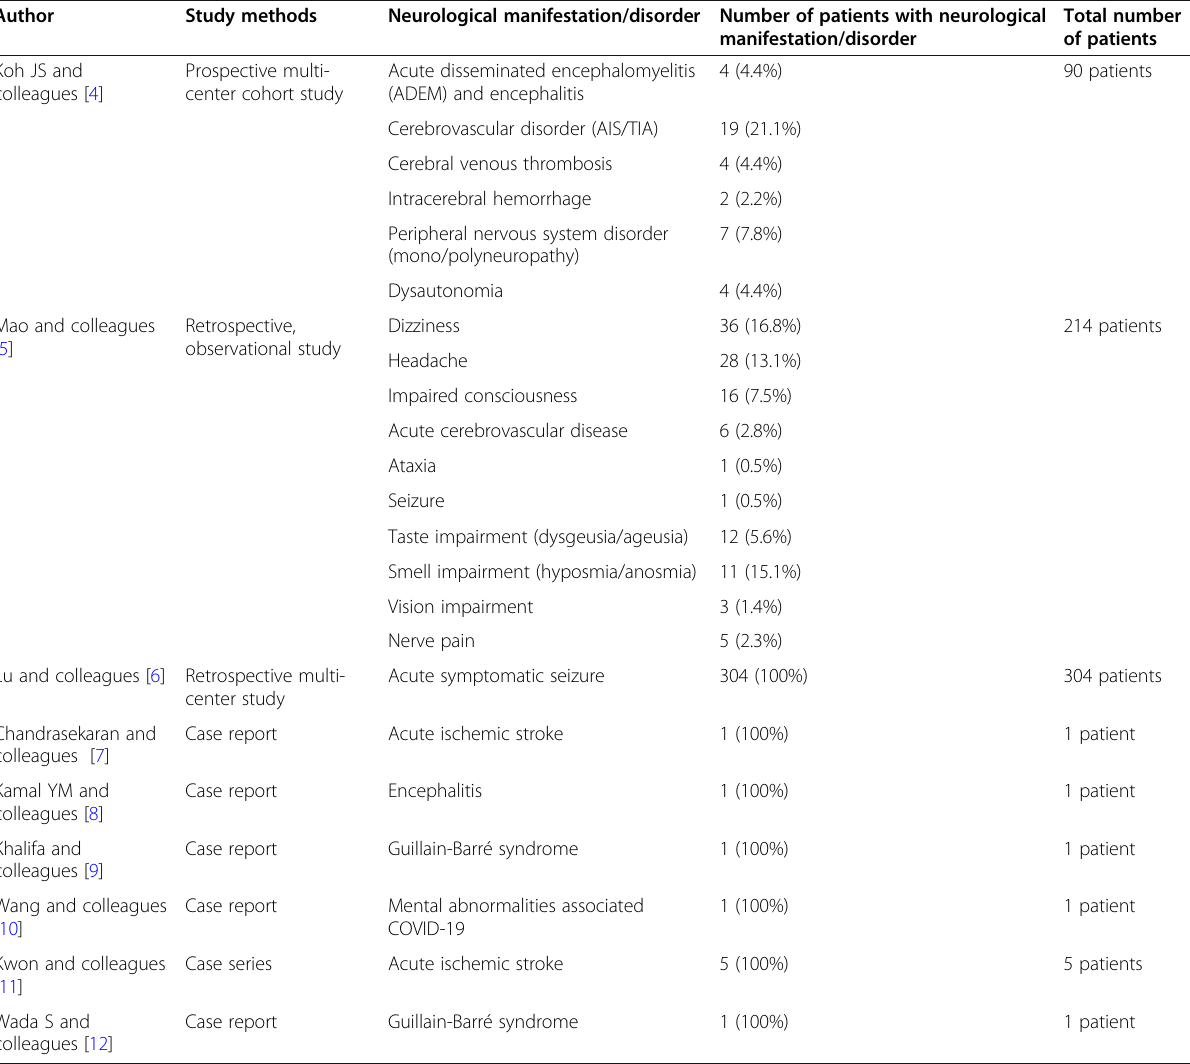
Table 2 Comparison of neurological manifestation/disorder to total patients of each study